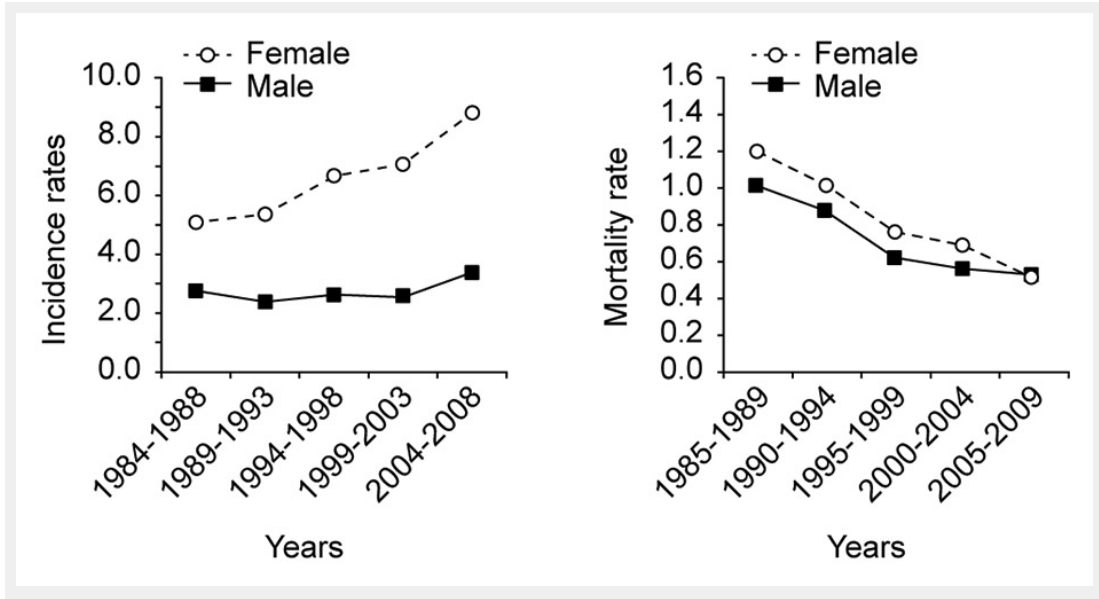
Figure 2 Incidence and mortality rate of thyroid cancer in Switzerland. Adapted from the National Institute for Cancer Epidemiology and Registration,